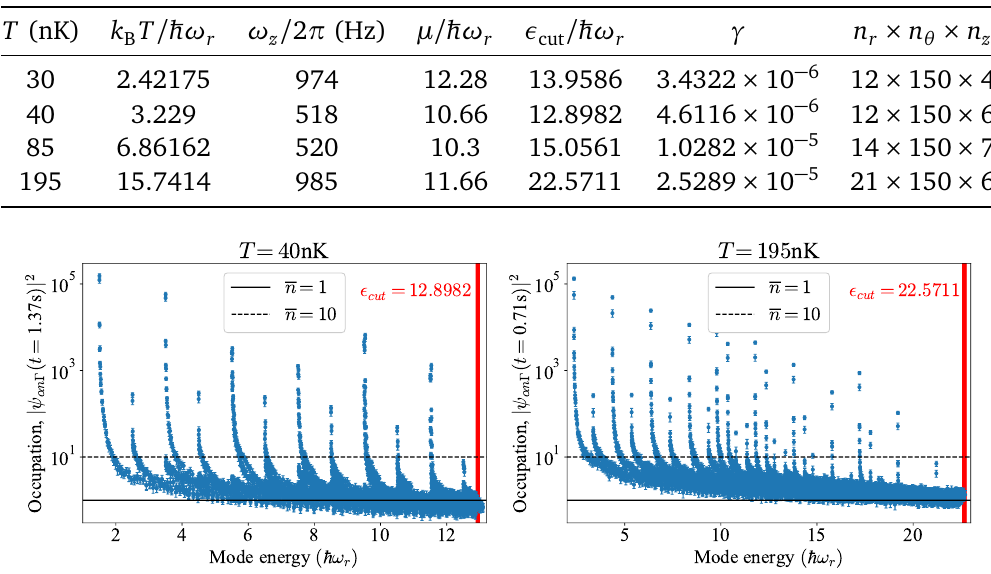
Table 1: Fixed parameters for the simulations performed in this work. Here n are the number of single-particle modes in the r , θ , z dimensions, respectively.